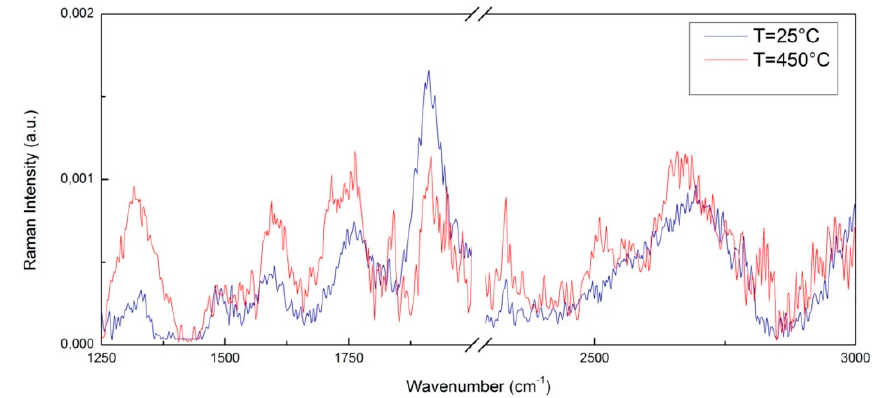
Figure 2. A comparison between the Raman spectrum of CNTs at T = 25 °C and at T = 450 °C.